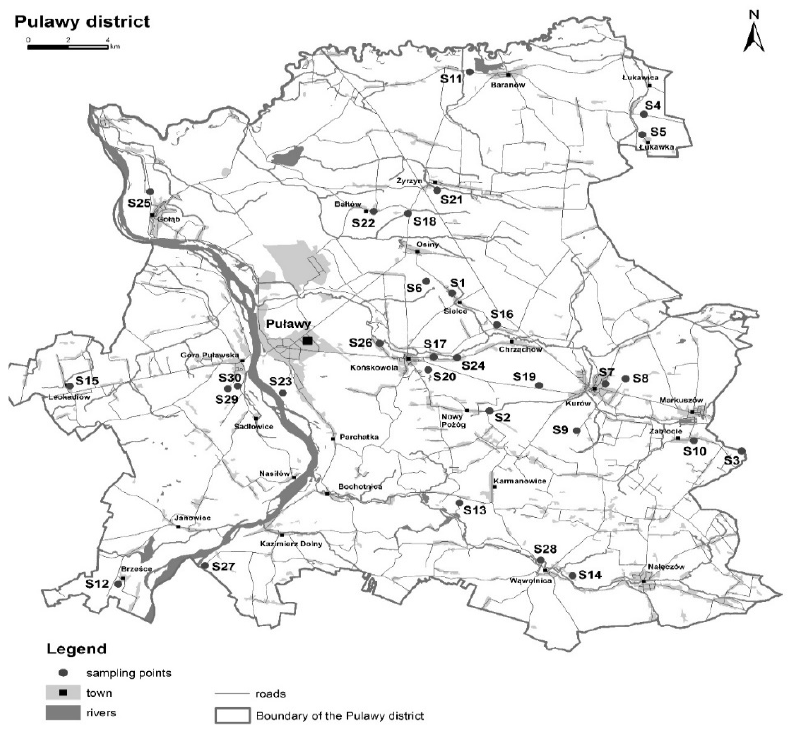
Figure 1. Location of sampling points in Puławy district (S1–S30) in